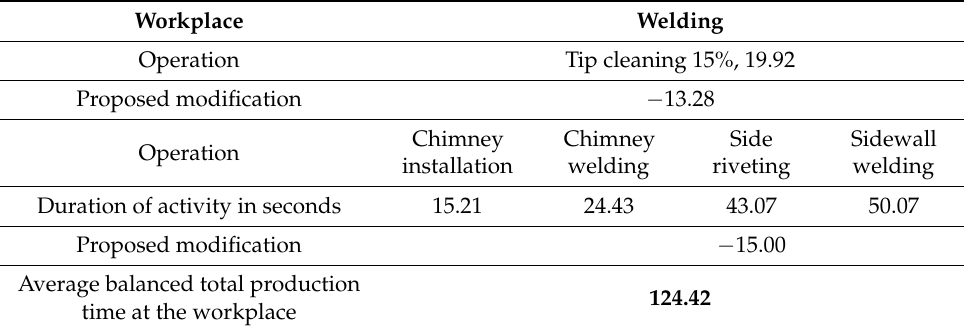
Table 6. Average balanced total production time at the Welding workplace.